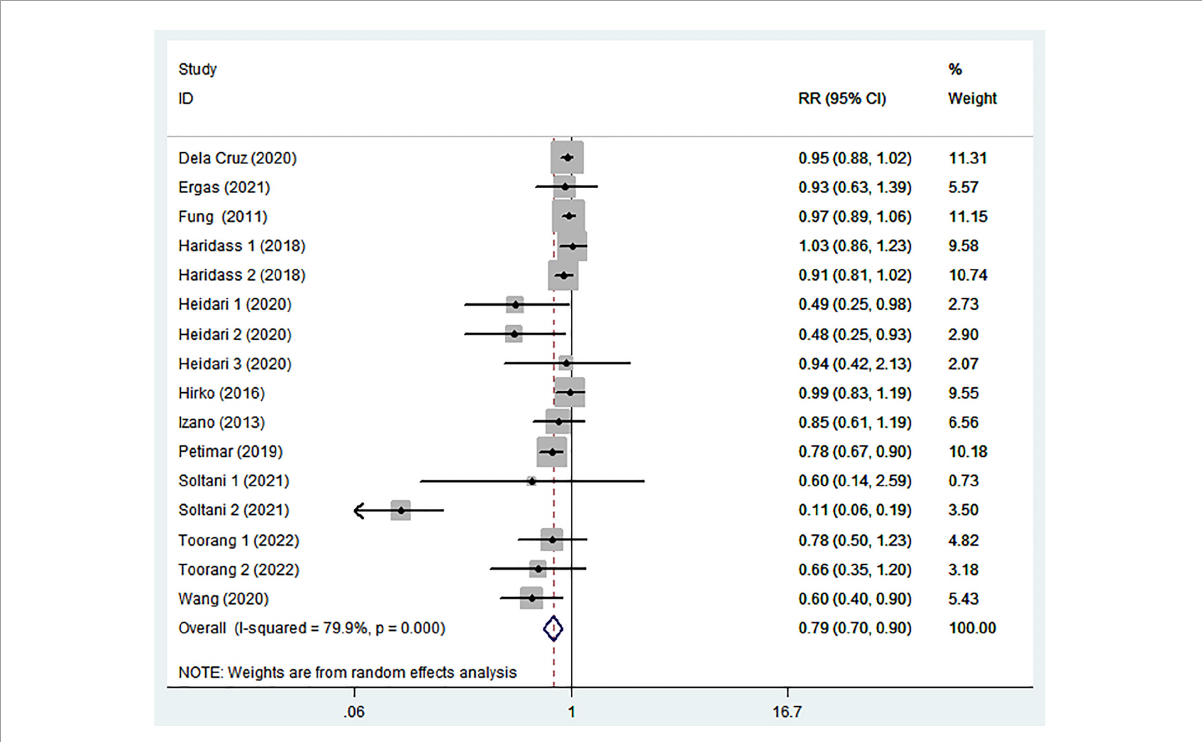
FIGURE2 Meta-analysis on the association between adherence to dietary approaches to stop hypertension (DASH) diet and breast cancer